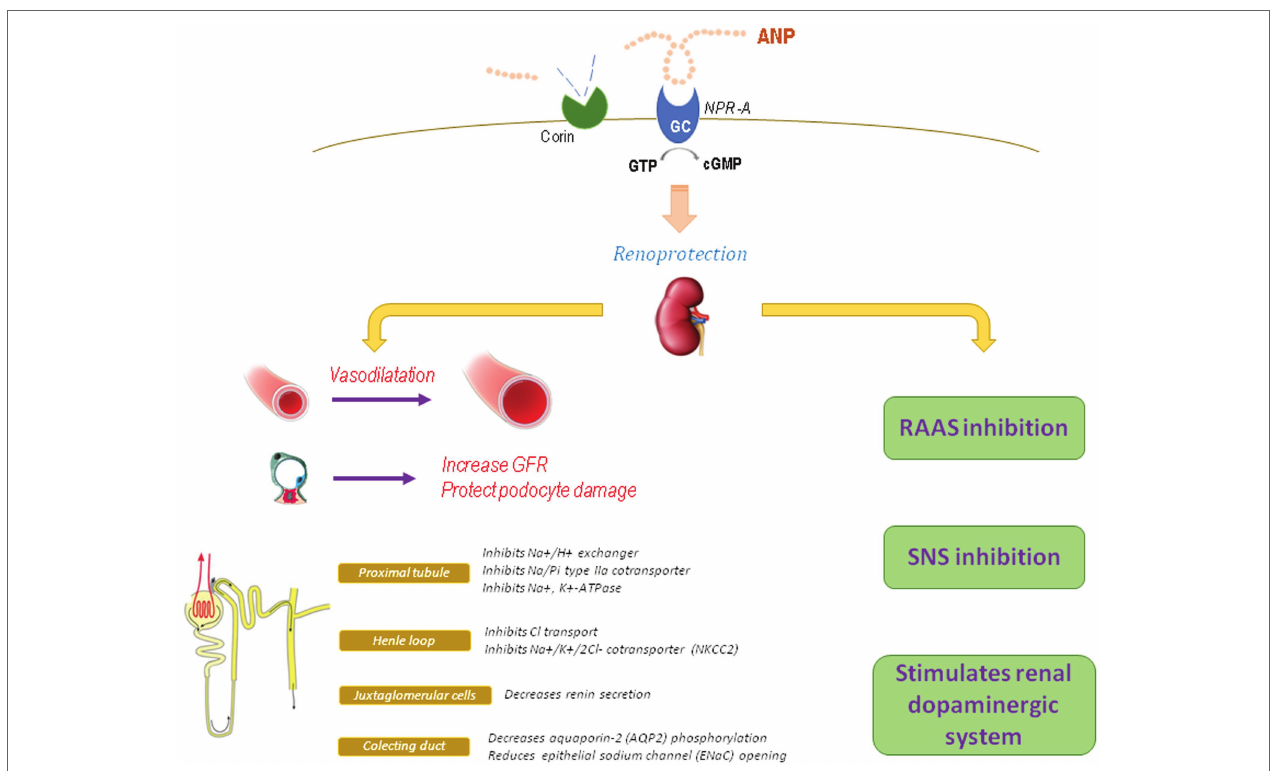
FIGURE 1 | Physiological actions of ANP. GFR, glomerular filtration rate; RAAS, renin-angiotensin-aldosterone system; SNS, sympathetic nervous